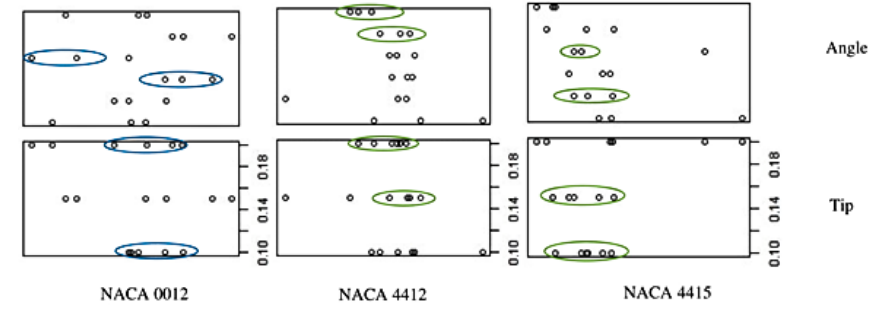
Figure 22. Scatter plot matrices for blade angle and blade tip size of three NACA airfoils.